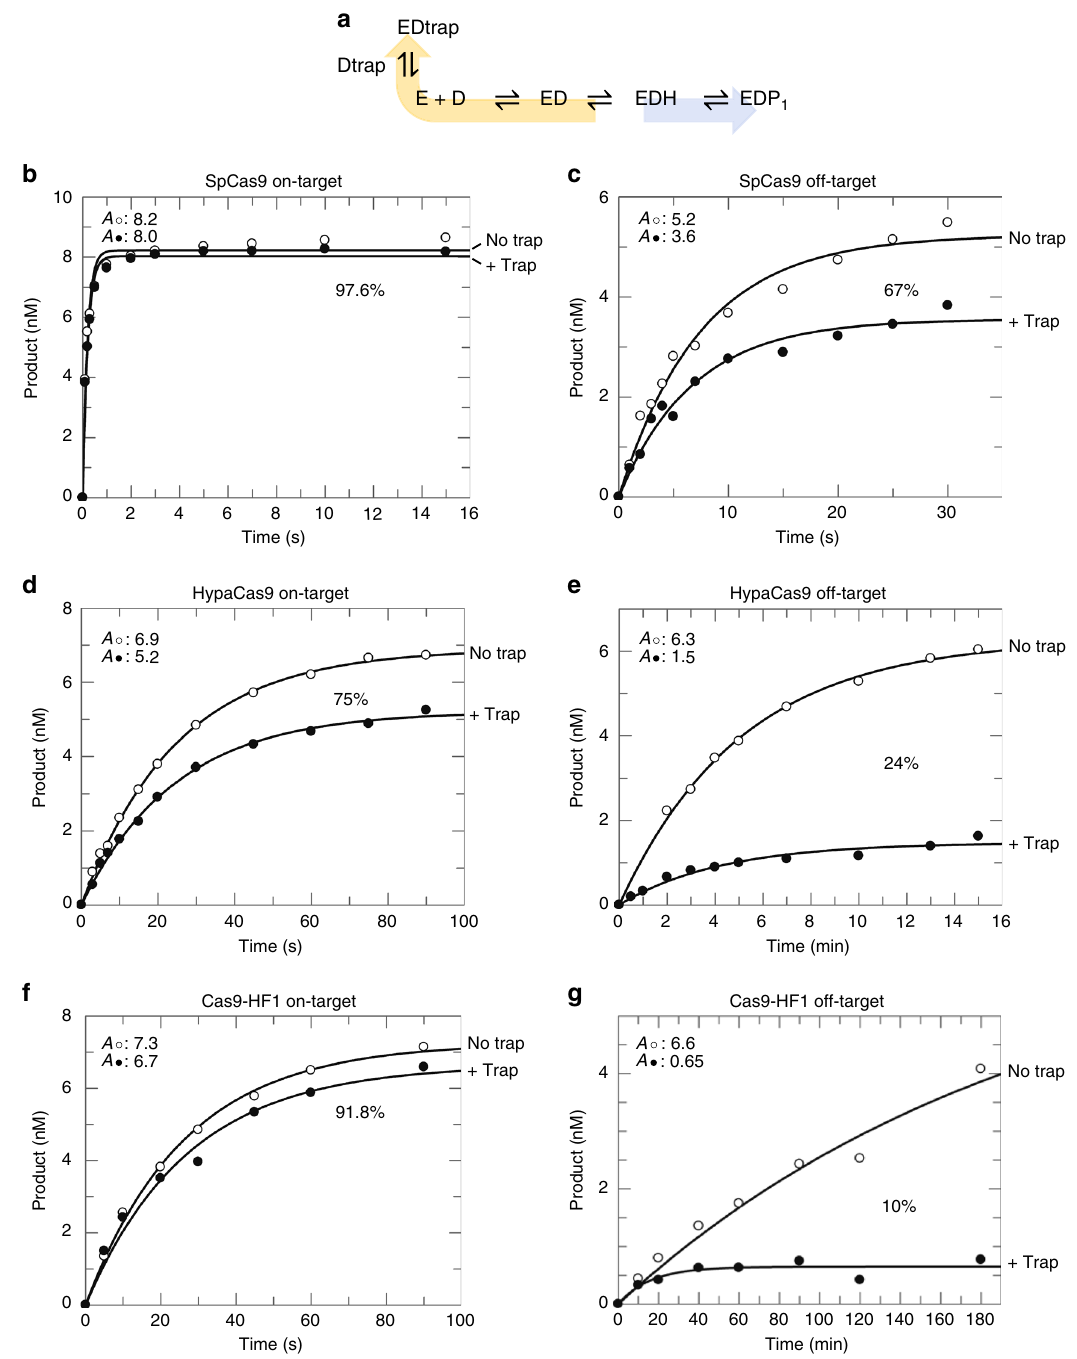
Fig. 4 Engineered Cas9s improve speci fi city through a decreased rate of DNA cleavage. a Schematic of DNA trap experiment. b, c SpCas9 cleavage of on-target (from Gong et al. 15 ) ( b ) or off-target ( c ) DNA. d, e HypaCas9 cleavage of on-target ( d ) or off-target ( e ) DNA. f , g Cas9-HF1 cleavage of on-target ( f ) or off-target ( g ) DNA. Enzyme (28 nM) and labeled DNA (10 nM) were incubated in the absence of Mg 2 + and the reaction was initiated by adding Mg 2 + in the presence or absence of an excess of unlabeled DNA trap. A (cid:129) and A ◦ represent the amplitude with ( fi lled circles) and without trap (open circles), respectively. The percentage indicates the fraction of pre-bound DNA committed to going forward for cleavage relative to the reaction in the absence of